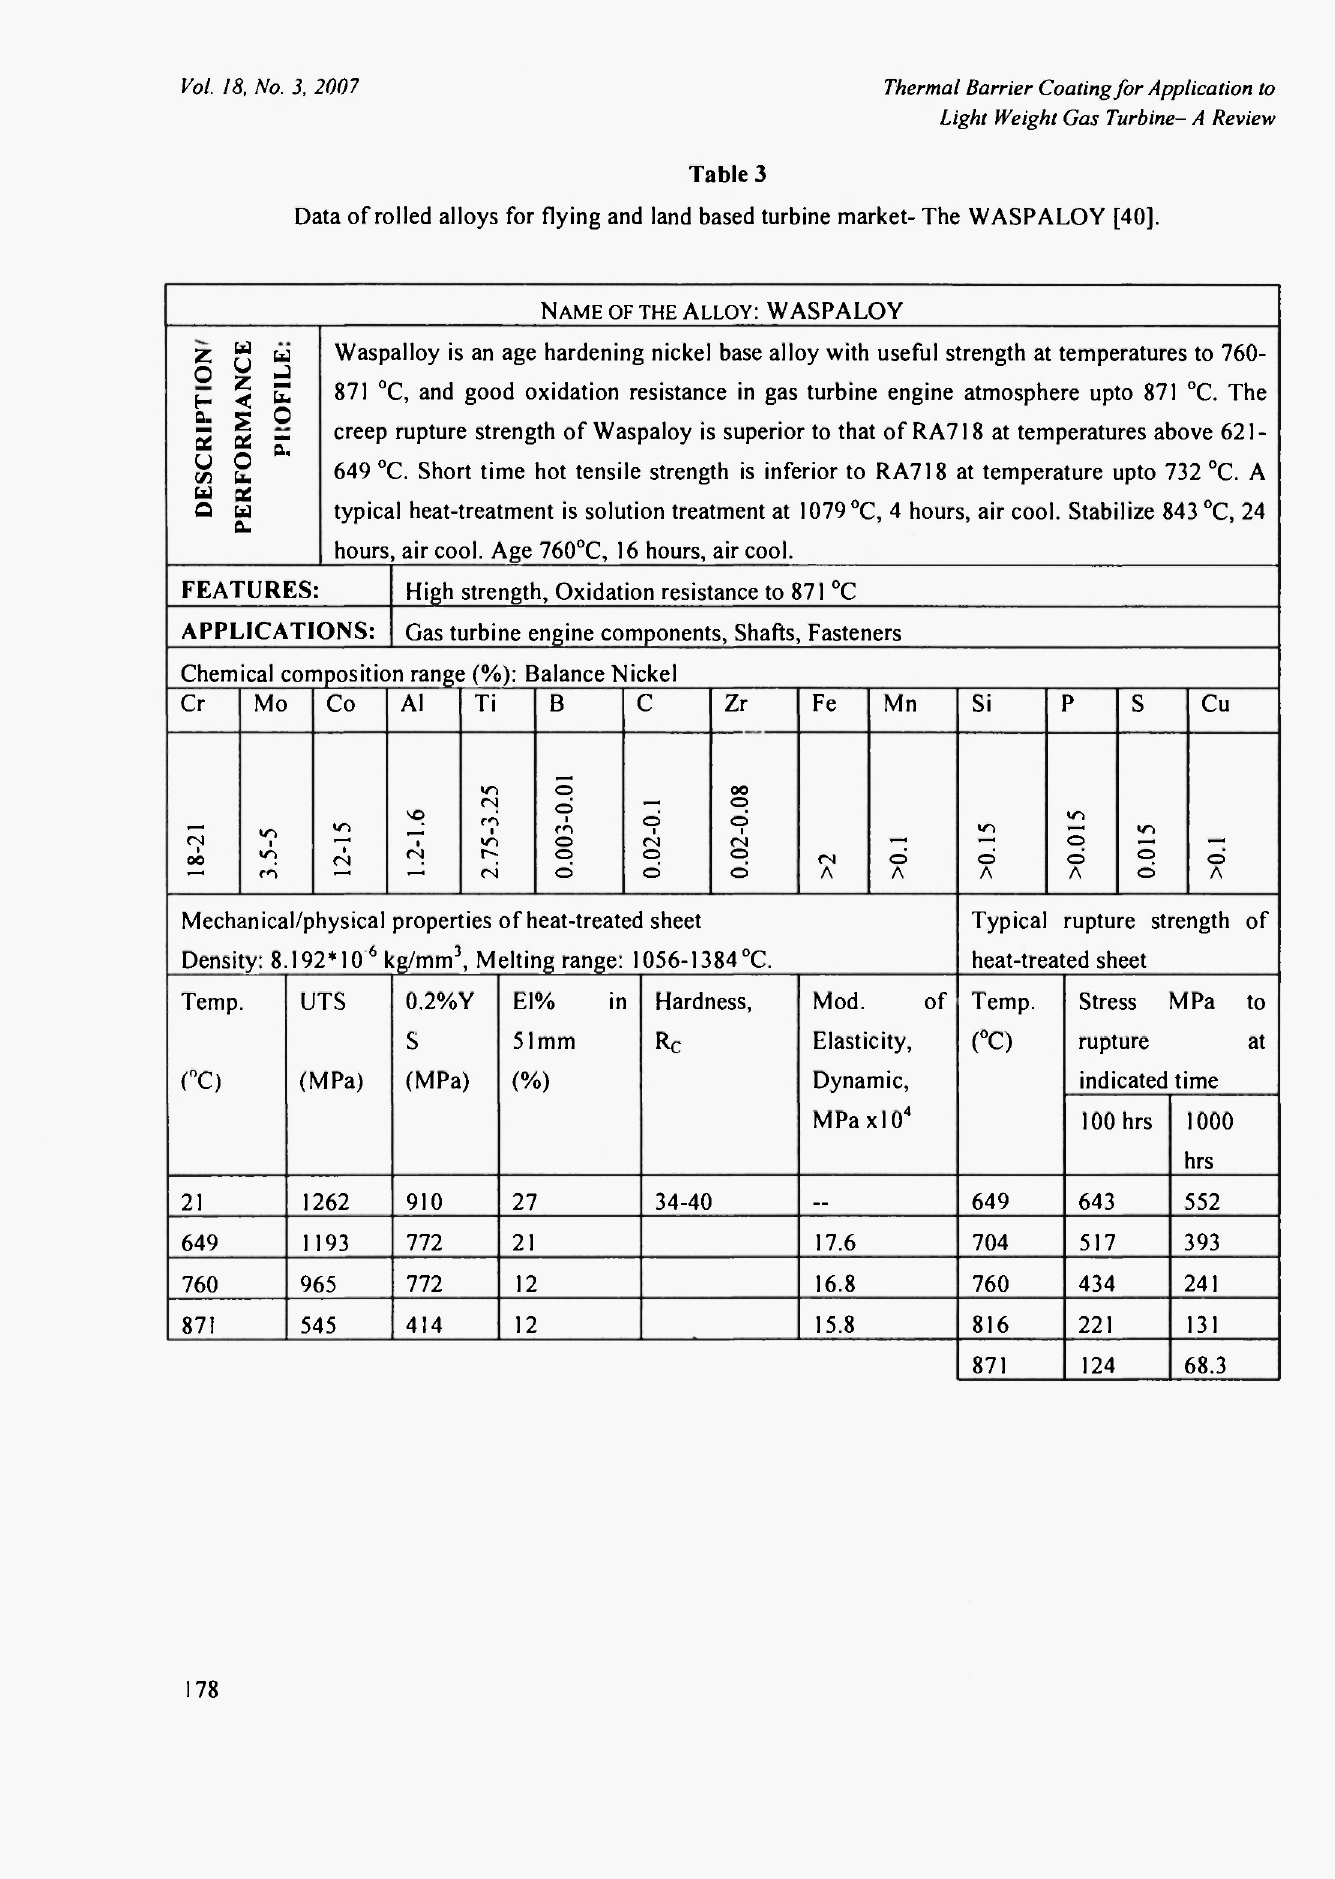
Data of rolled alloys for flying and land based turbine market- The WASPALOY